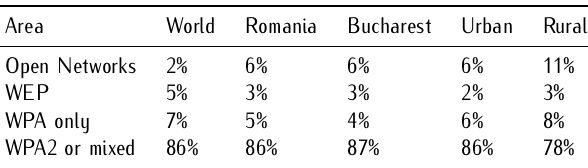
Table 1. Open, WEP, WPA and mixed networks statistics